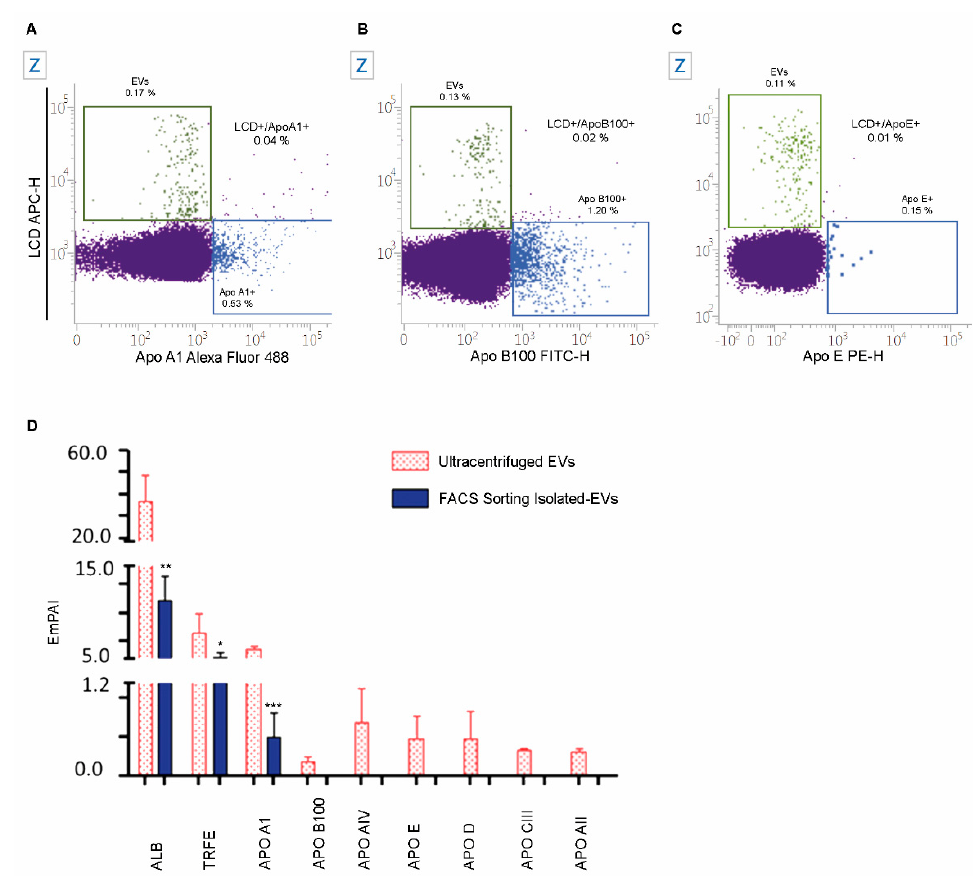
Figure 3. Analysis of the EVs contaminants. Dot-plots represent the parallel analysis of LCD and Apolipoprotein A1 (ApoA1, ( A )) or Apolipoprotein B100 (ApoB100, ( B )) or Apolipoprotein E (ApoE, ( C )) on the population of events resulting phalloidin negative in the “Platelet free area” gate. ( D ). Bars represent the emPAI comparison of known EVs contaminants between sorted EVs (blue bars) and EVs separated by ultracentrifugation (pink bars). Student’s t -test, * p ≤ 0.05, ** p ≤ 0.01, *** p ≤ 0.001. Data are representative of three separate experiments.